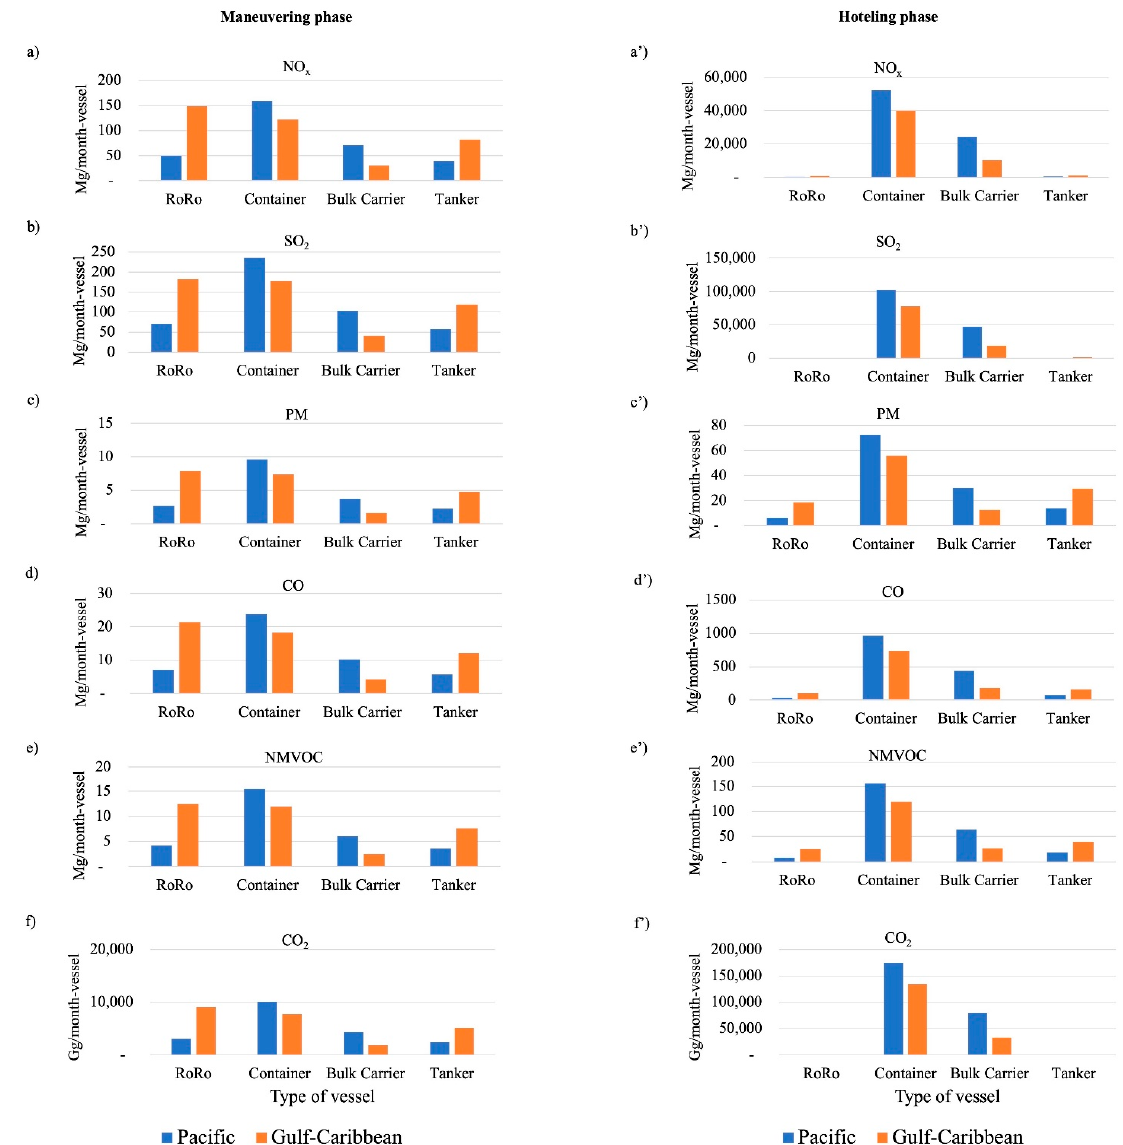
Figure 4. Atmospheric emissions by type of vessel in maneuver for ( a ) NO x , ( b ) SO 2 , ( c ) PM, ( d ) CO, ( e ) NMVOC and ( f ) CO 2 , and hoteling for ( a’ ) NO x , ( b’ ) SO 2 , ( c’ ) PM, ( d’ ) CO, ( e’ ) NMVOC and ( f’ ) CO 2 .